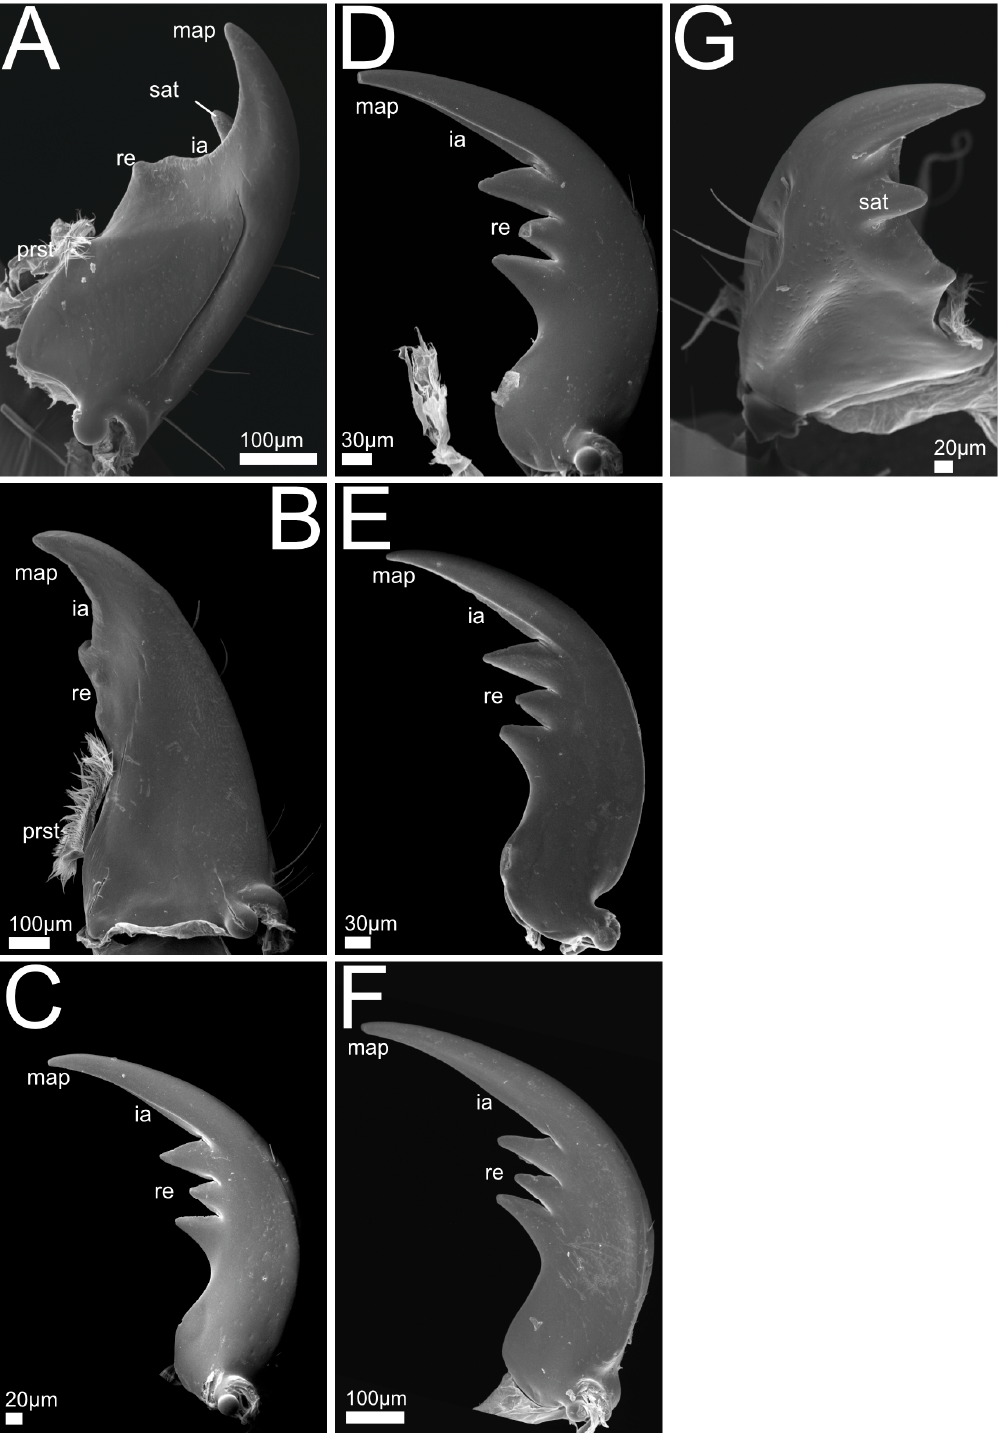
Figure 9. SEM views of Xantholinini, Othiini and Stilicina mandible. Images A – F ventral, ( G ) dorsal aspects of mandible. ( A ) Gyrohypnus fracticornis ; ( B ) Othius punctulatus ; ( C ) Rugilus erichsonii ; ( D ) R. mixtus ; ( E ) R. orbiculatus ; ( F ) R. rufipes ; ( G ) G. fracticornis . Abbreviations: ia: incisor area; map: mandibular apex; prst: prostheca; re: retinaculum; sat: subapical tooth.